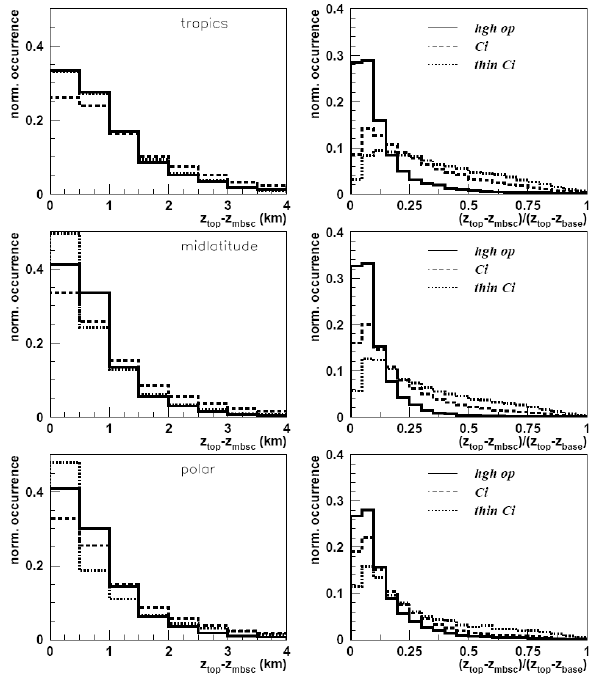
Figure 9: Normalized frequency distributions of the height of maximum backscatter in relation to the Fig. 9. Normalized frequency distributions of the height of max- cloud top, separately for high opaque clouds (full line), cirrus (broken line) and thin cirrus (dotted line), imum backscatter in relation to the cloud top, separately for high as absolute difference z top -z mbsc (left panel) and as relative difference (z top -z mbsc )/(z top -z base ) (right panel). opaque clouds (full line), cirrus (broken line) and thin cirrus (dotted Distributions are presented for three different latitude bands: 30°N-30°S (upper panels), 30°-60° (middle line), as absolute difference z top − z mbsc (left panel) and as relative panels) and 60°-90° (lower panels). difference ( z top − z mbsc ) /( z top − z base ) (right panel). Distributions are presented for three different latitude bands: 30 ◦ N–30 ◦ S (upper panels), 30 ◦ –60 ◦ (middle panels) and 60 ◦ –90 ◦ (lower